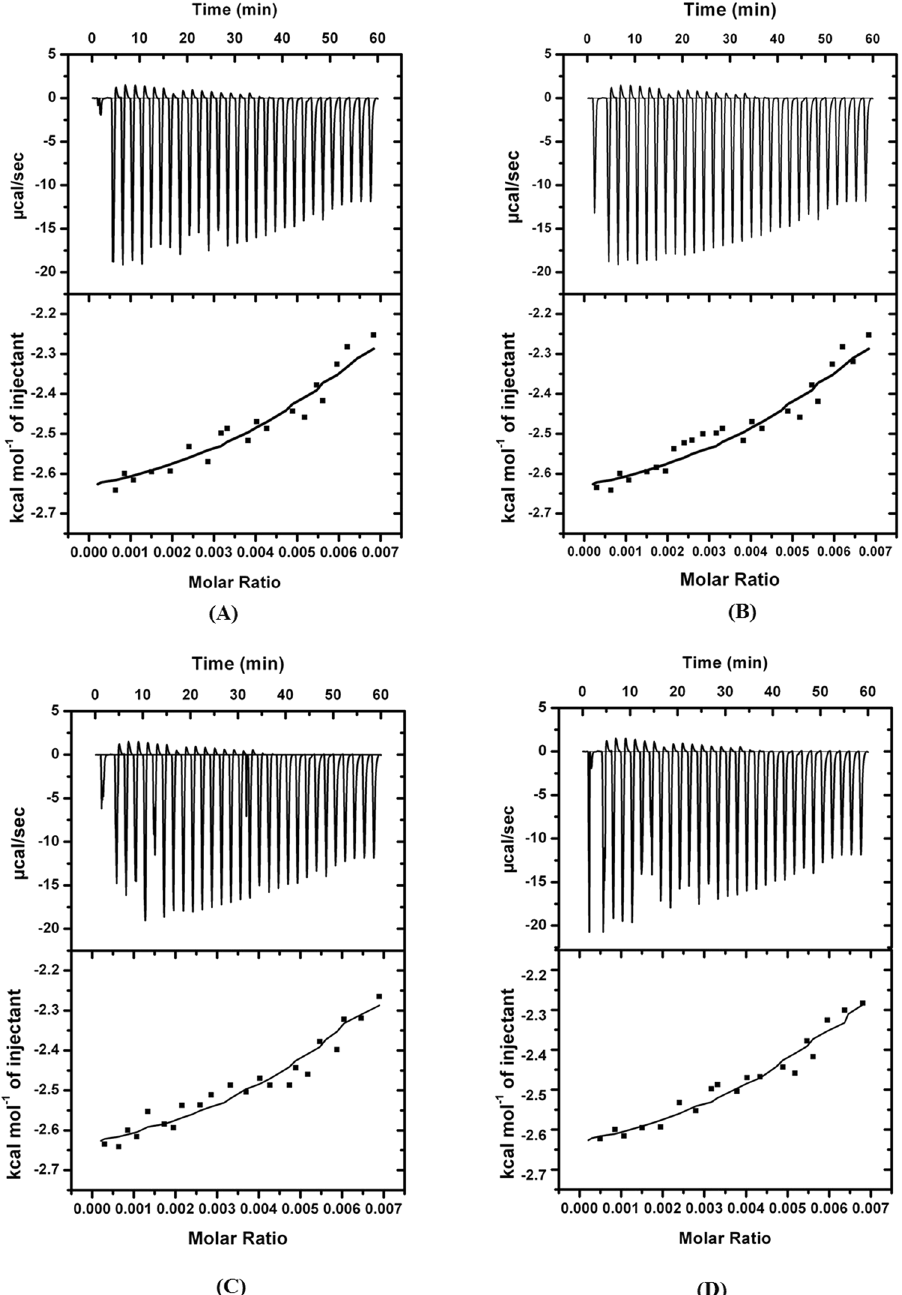
Figure 6. Isothermal titration calorimetry of NDM-1 protein with M1, M17, M21, M61, shown in panel as ( A , B , C and D ), respectively at 298 k temp, represent ITC